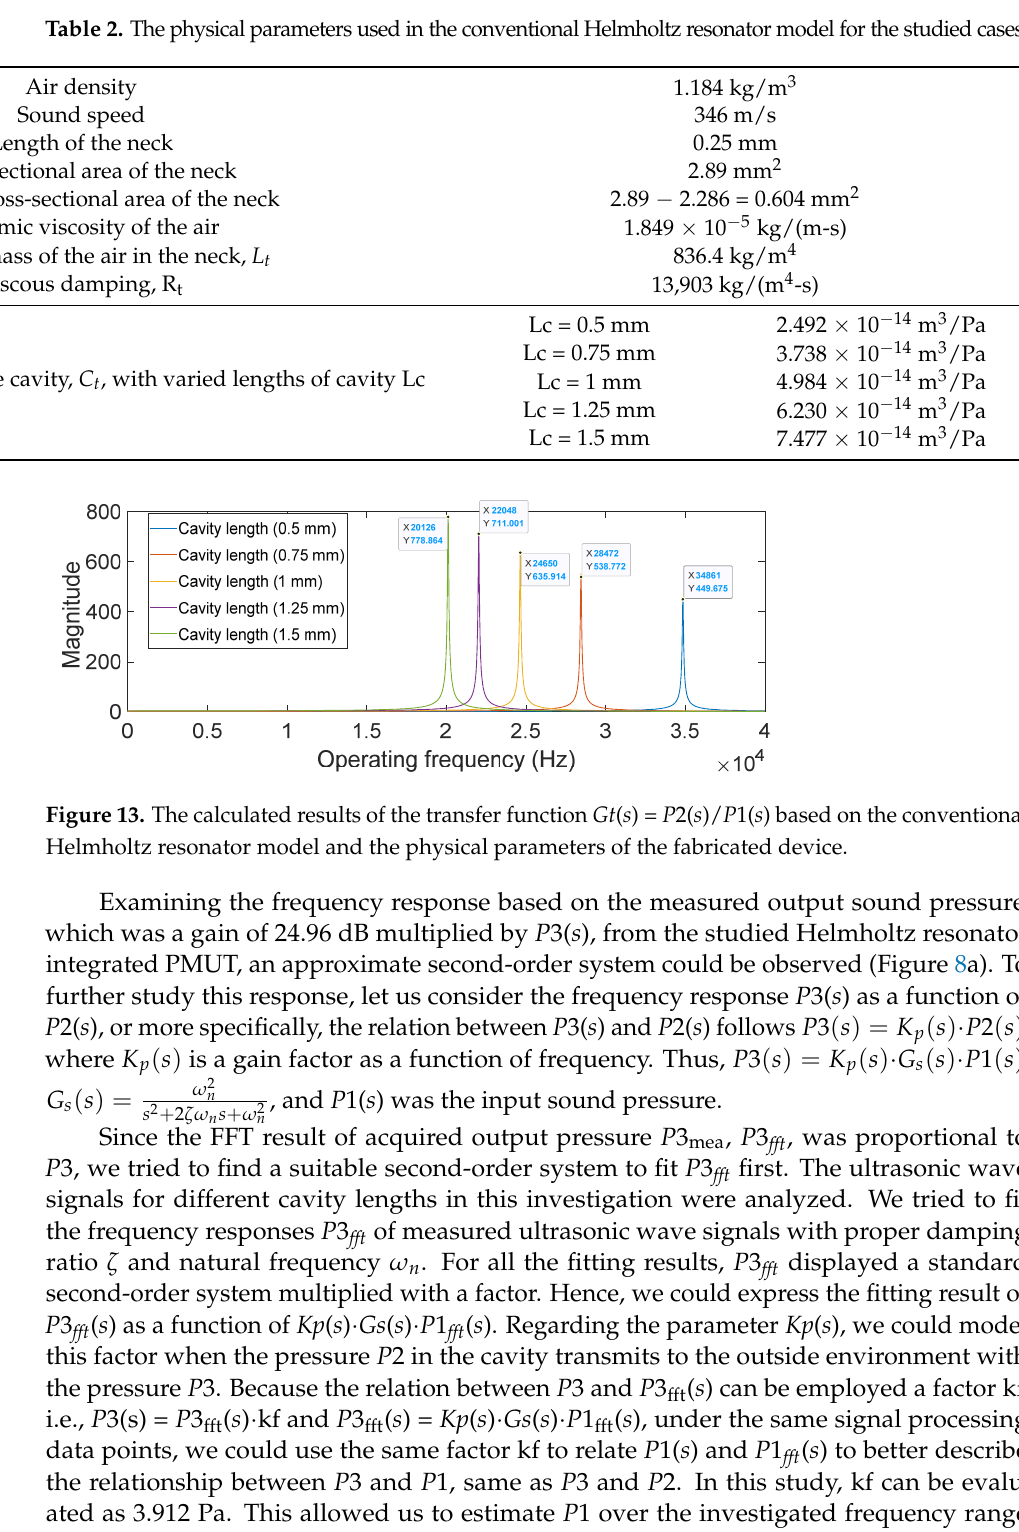
Table 3. The parameters Kp , ζ , ω n, and ω p of the investigated PMUT operated in the open-cavity condition and with Helmholtz chamber for five different volumes (cavity lengths).